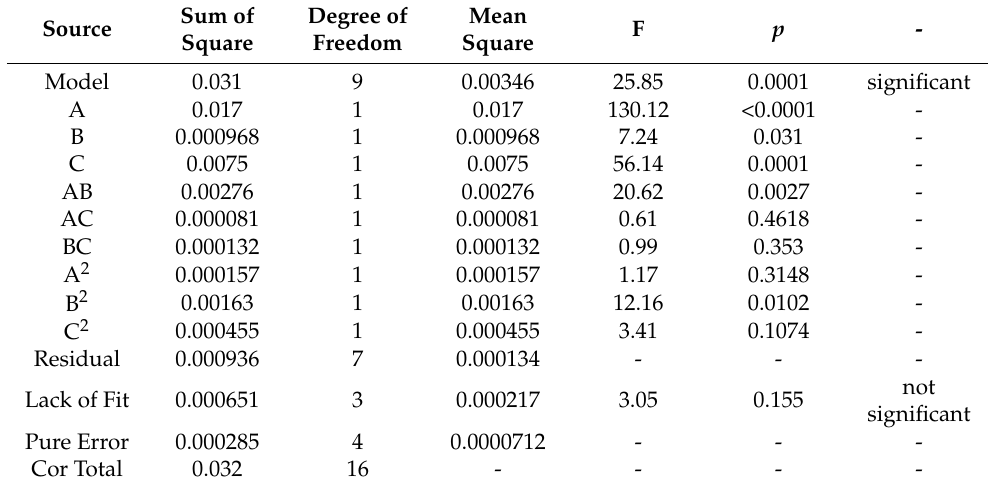
Table 6. Analysis of variance for dilution rate optimization model.